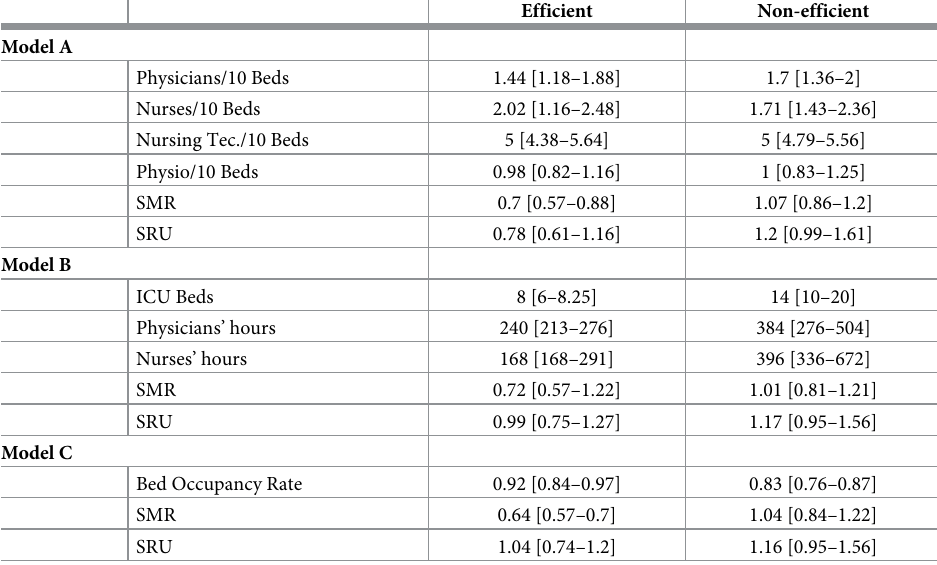
Table 4. Median values (and interquartile ranges, in brackets) of inputs and outputs divided in two groups: effi- cient and non-efficient units in each